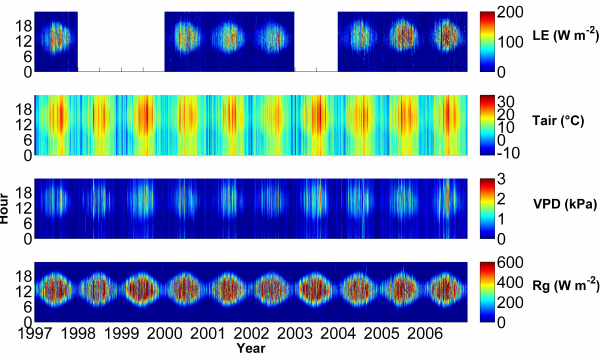
Fig. 2. Latent heat (LE-Wm − 2 ) , air temperature ( T air - ◦ C), vapour pressure deficit (VPD- kPa) and incident (global) radiation ( Rg - Wm − 2 ) during the study period. Data reflect half-hourly measure- ments from the top of a 41m tower located within the study site by year (abscissa) and hour of the day (ordinate). The color bar at the right of the figure indicates the magnitude of the response for each